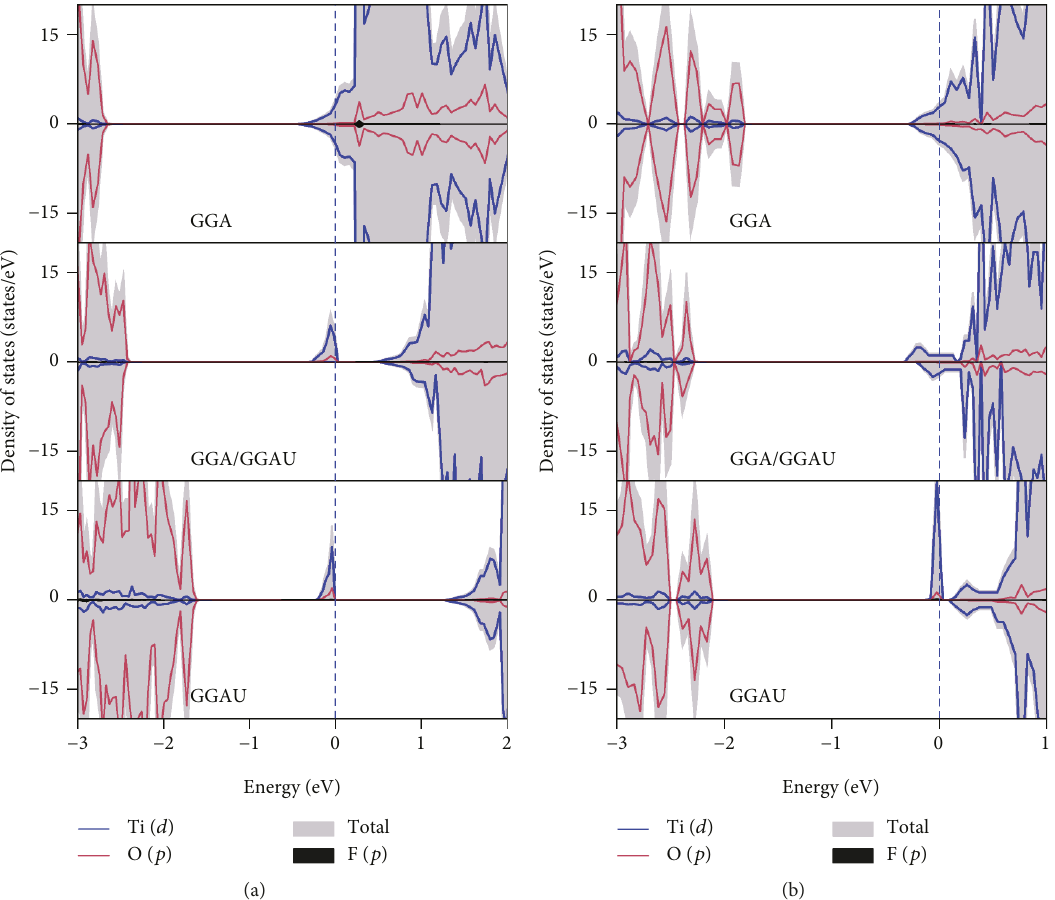
Figure 4: The total and partial density of states of the three relaxation methodologies for F-doped anatase TiO (b) The TiO (101) 2